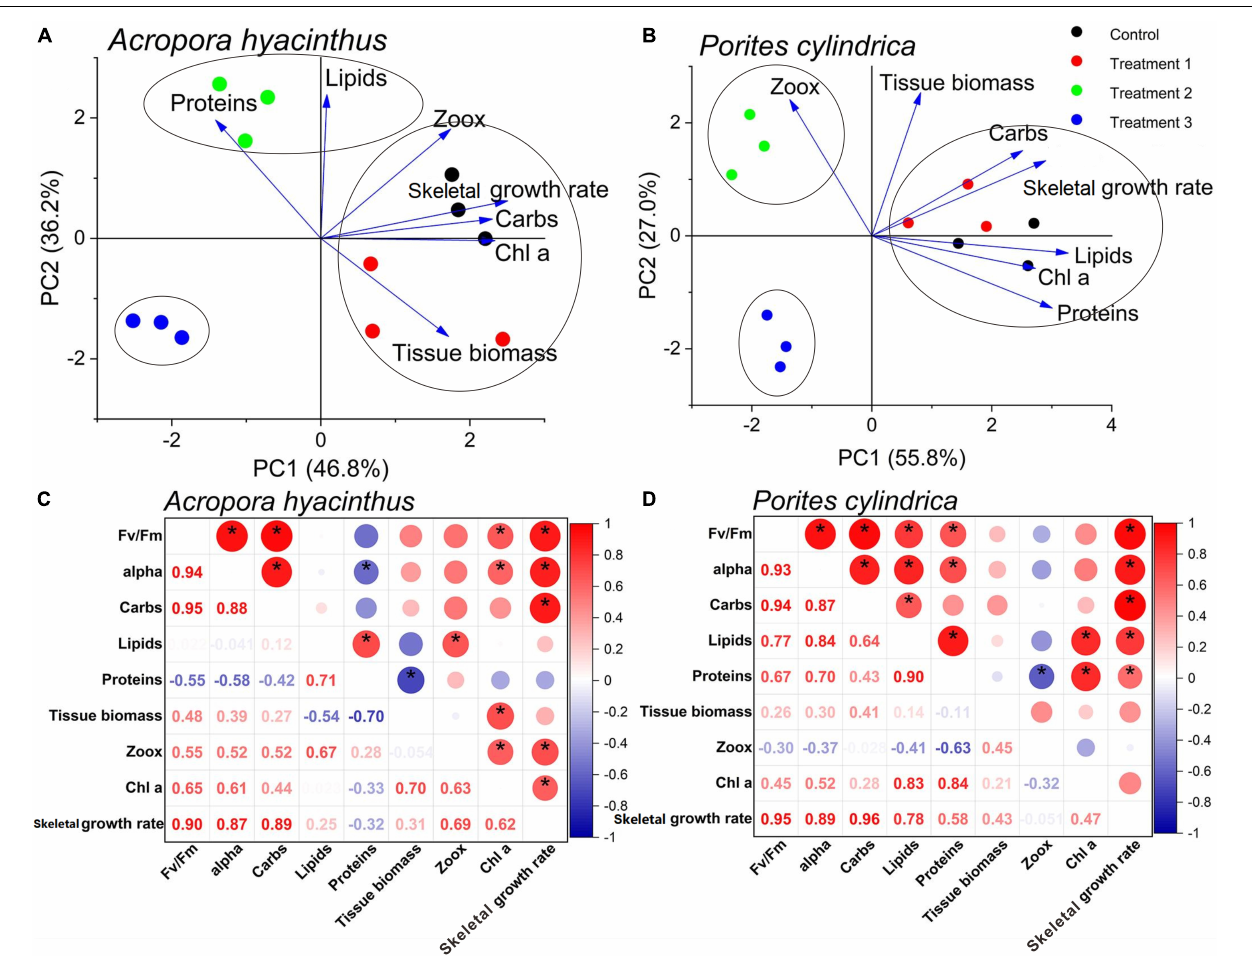
FIGURE 5 | PCA (A,B) and correlation analyses (C,D) of physiological and photosynthetic parameters. The dots of the same color means different biological replicates in the same group. * indicates that correlation coefficient of two parameters is over